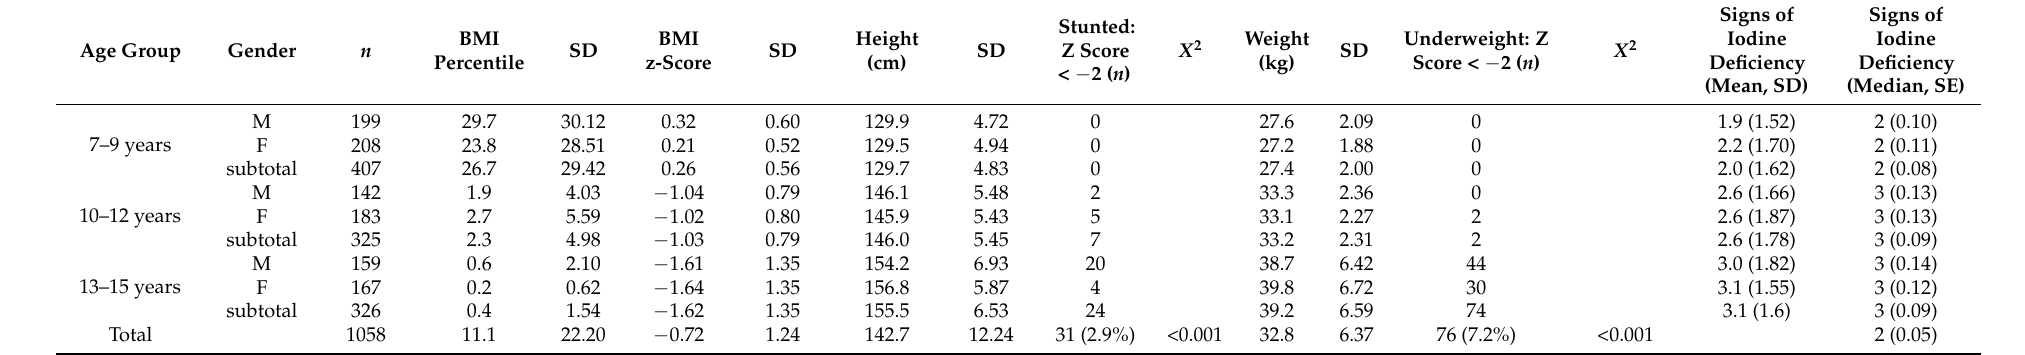
Table 2. Participants’ growth based on age groups ( n = 1058).